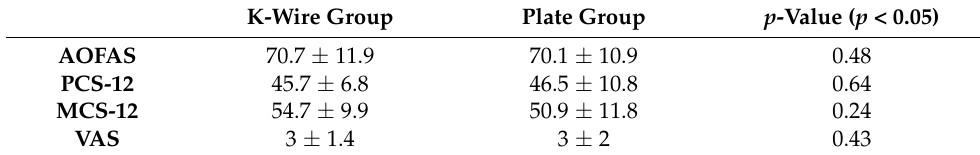
Table 2. KG and PG clinical outcomes and Sanders classification sub ‐ groups.